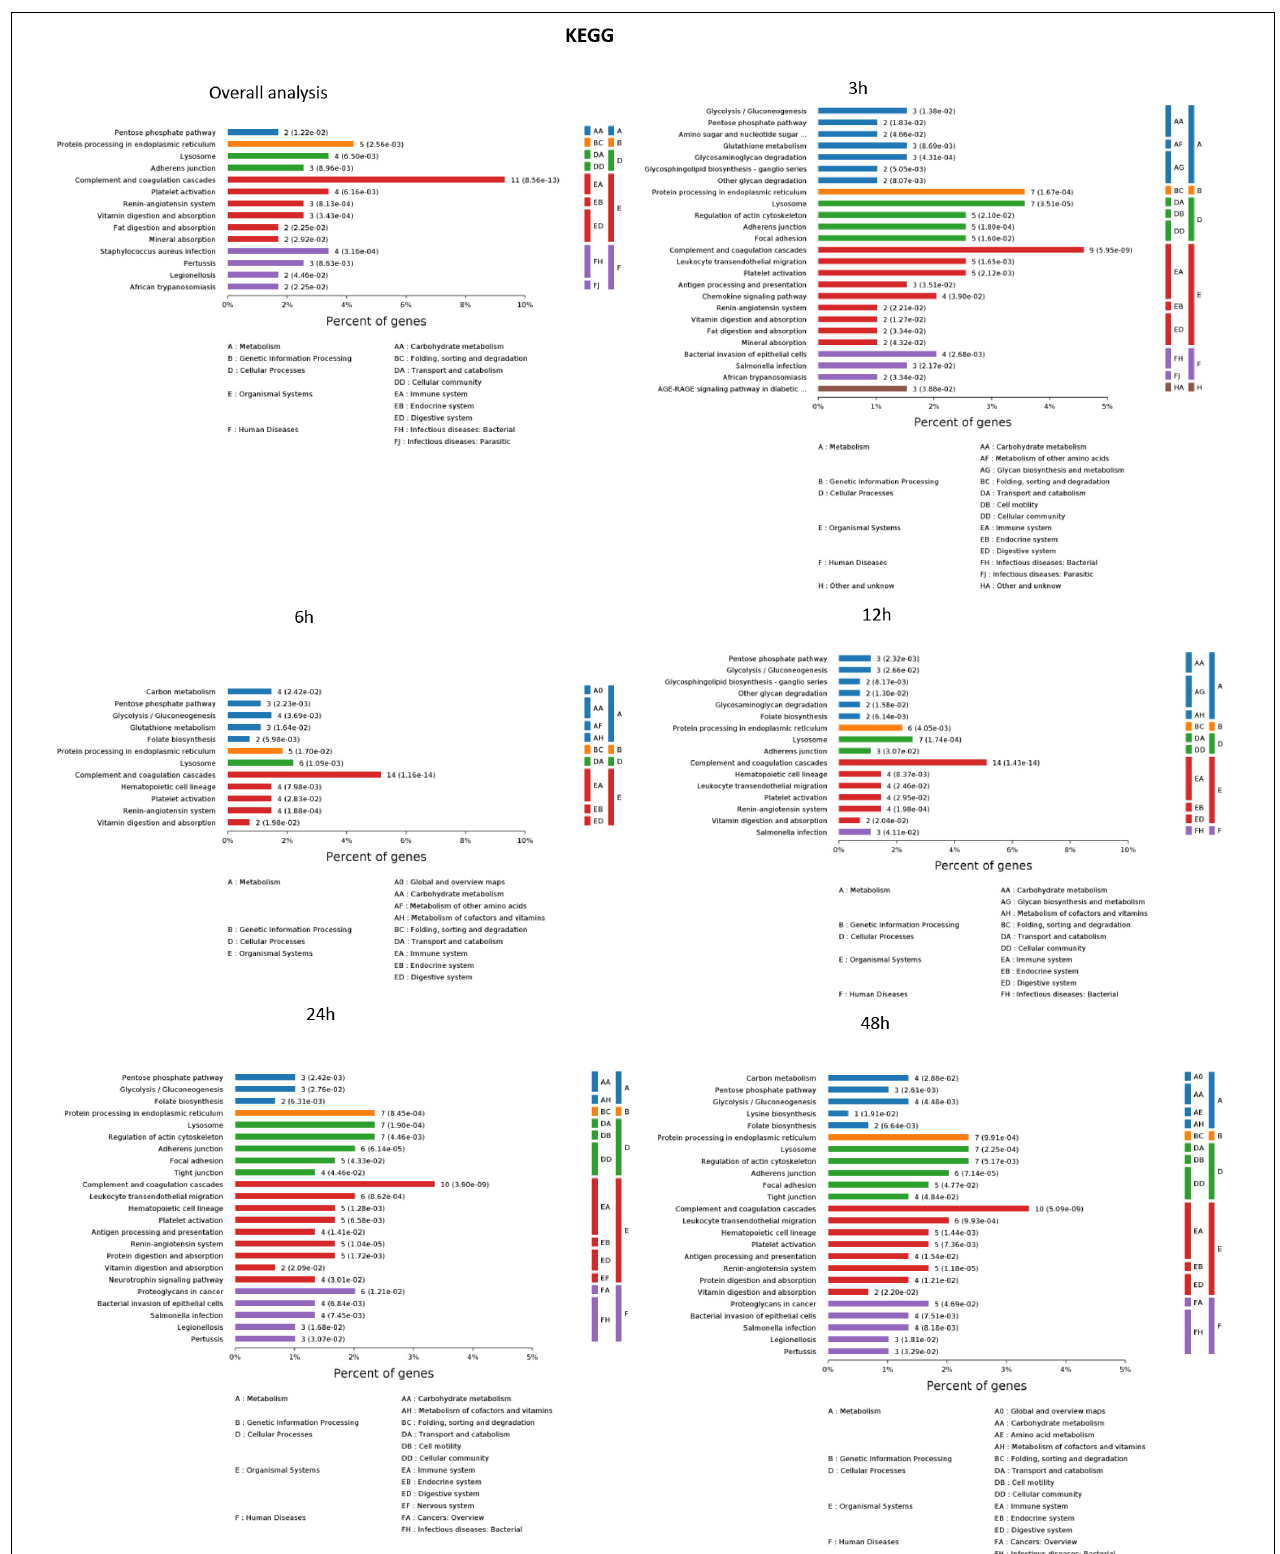
FIGURE 5 | The KEGG enrichment analysis of significantly changed pathways overall and at the indicated time (3, 6, 12, 24, and 48 h) compared with 0 h. P < 0.05.